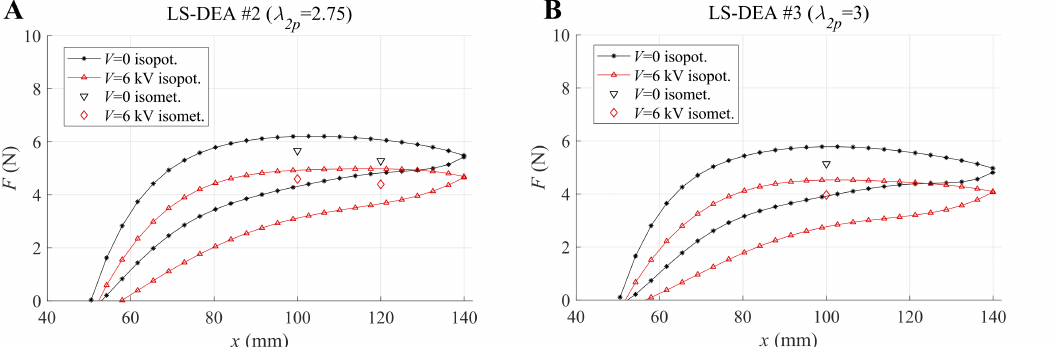
Figure 8. Comparison of experimental isopotential tensile cycles and isometric measurements at V = 0 kV and V = 6 kV for prototypes LS-DEA #2 ( A ) and LS-DEA #3 ( B ). Isolated markers refer to different isometric measurements at different voltages and blocking